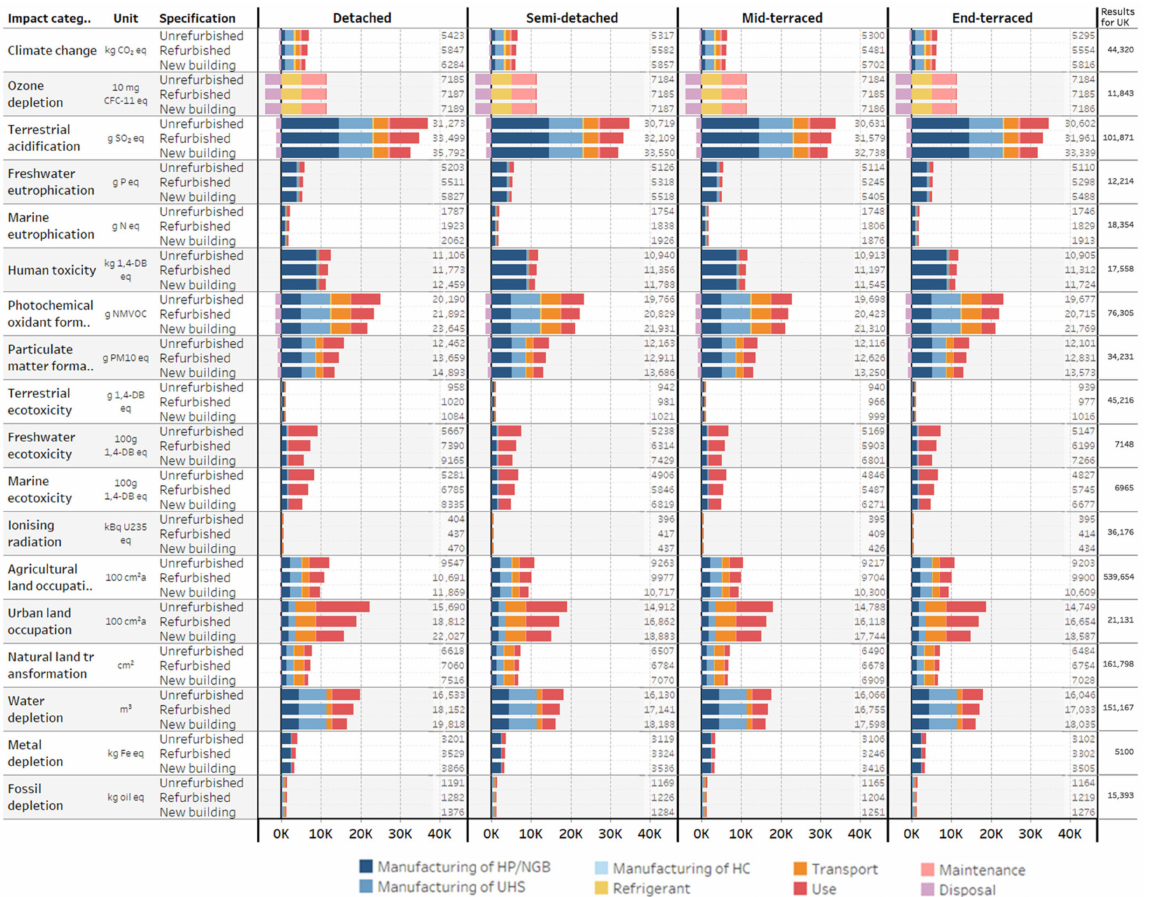
Figure 10. Lifecycle environmental impacts of heat pump uptake scenarios by house